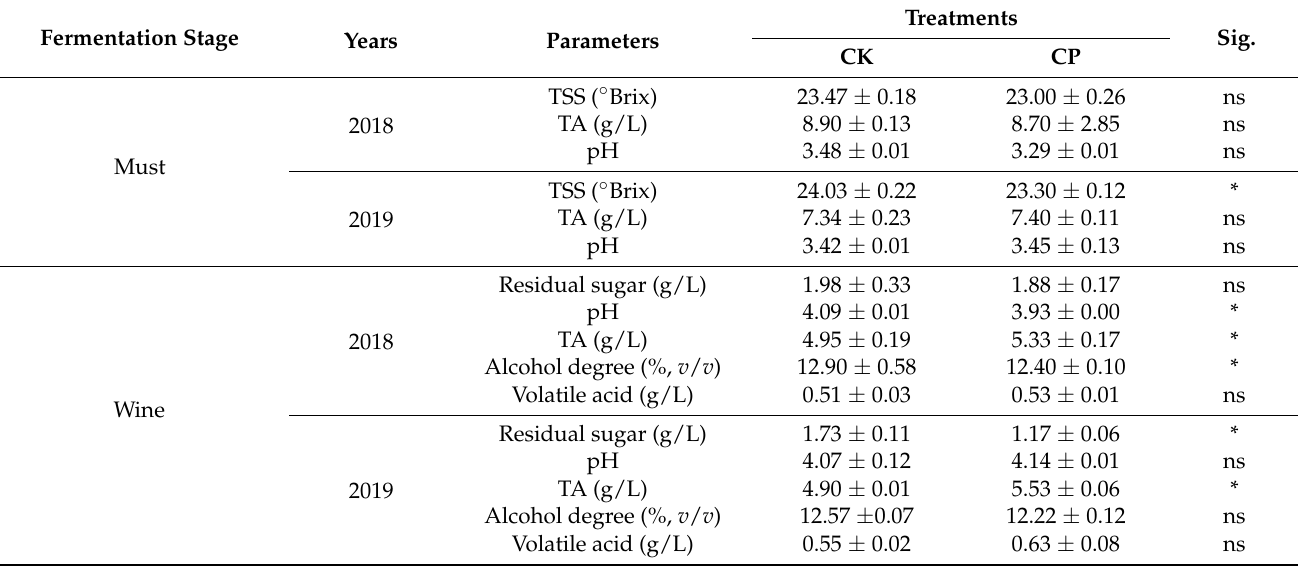
Figure 7. PCA analysis based on aroma compounds and flavonoid compounds by CK and CP in 2018-2019.